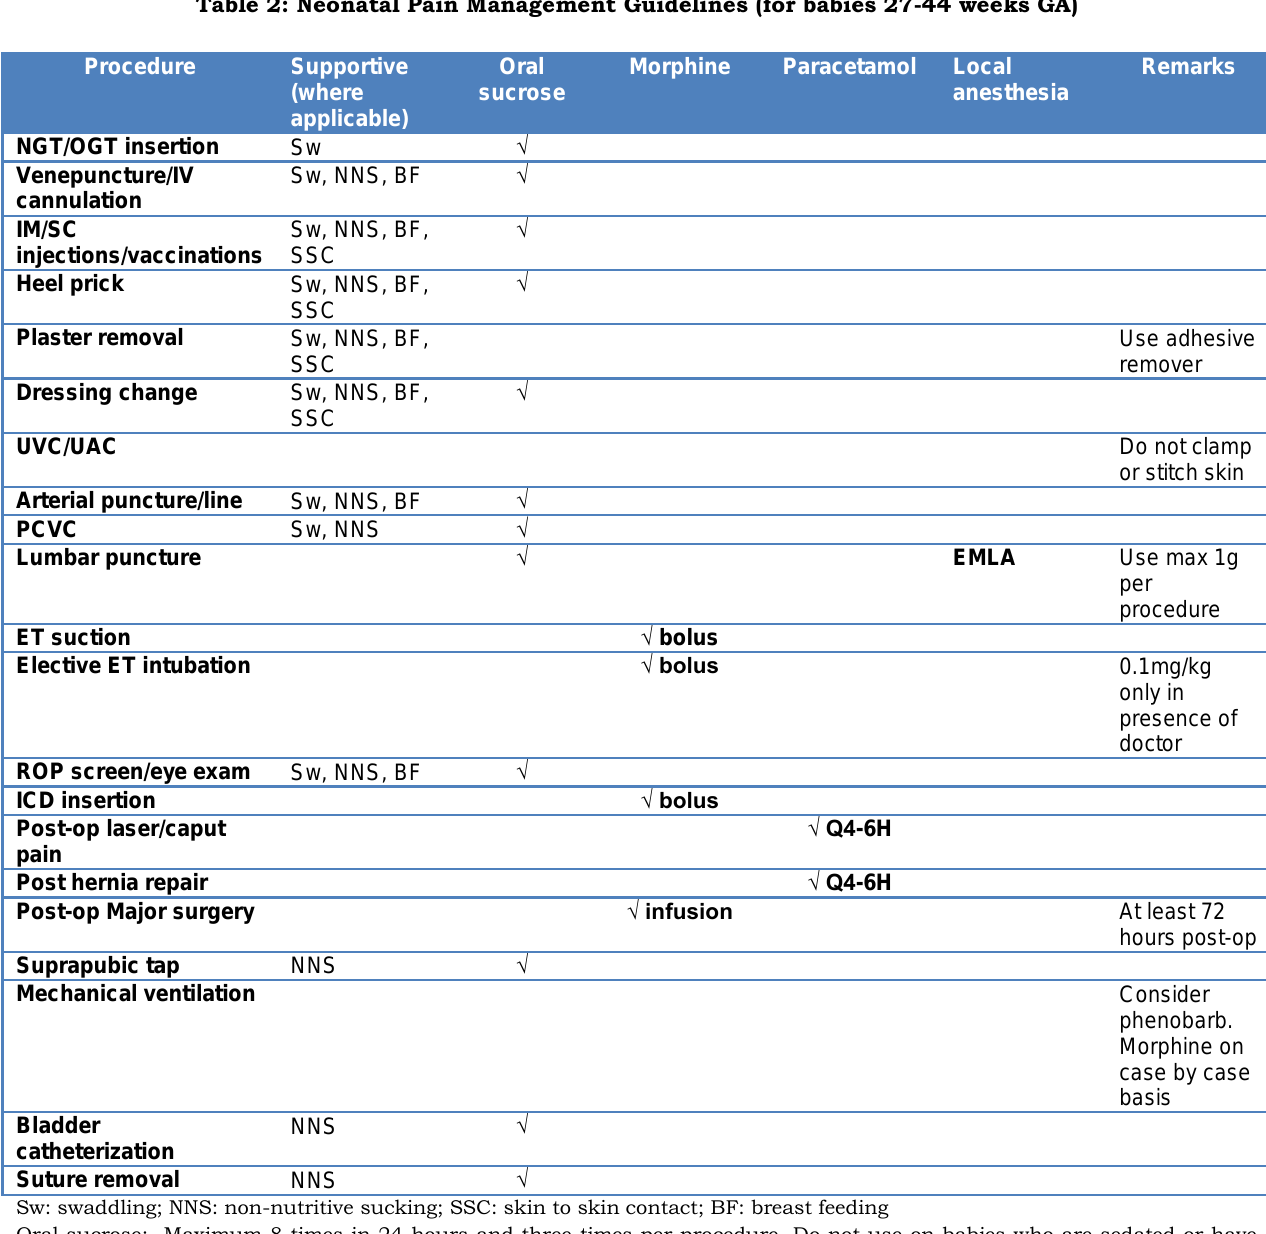
Table 2: Neonatal Pain Management Guidelines (for babies 27-44 weeks